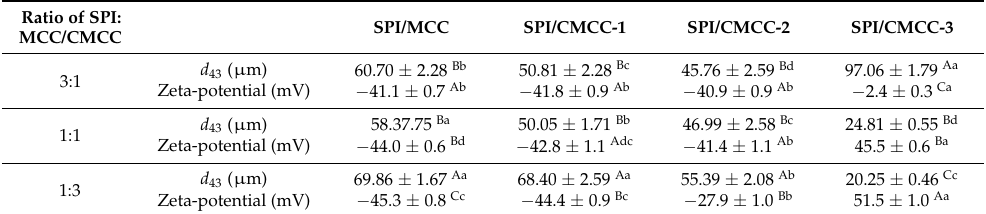
Table 1. The droplet size and zeta-potential of emulsions stabilized by SPI and MCC/CMCC complexes at mass ratios of 3:1, 1:1, and 1:3.